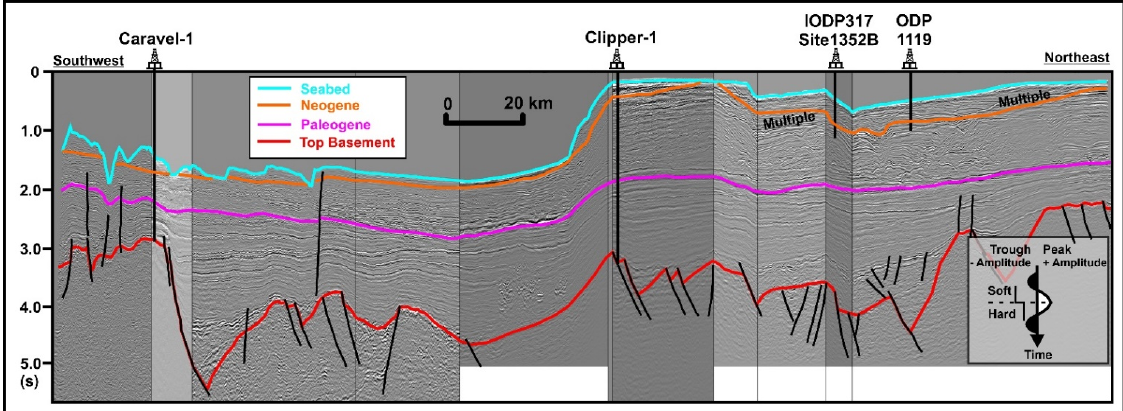
Figure 2. Regional SW-NE seismic-section through the study area. See Figure 1a for section location.